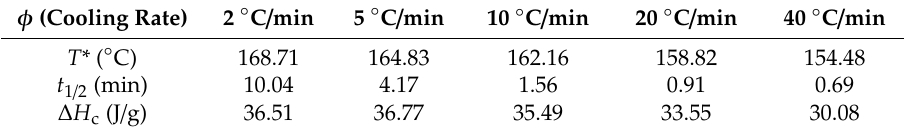
Figure 2. Results of the non-isothermal crystallisation experiments. ( a ) Heating endotherms for the second heating cycle. ( b ) Cooling exotherms during crystallisation. ( c ) Percentage of crystallinity X ( t ) as a function of temperature. ( d ) Percentage of crystallinity X ( t ) as a function of time.